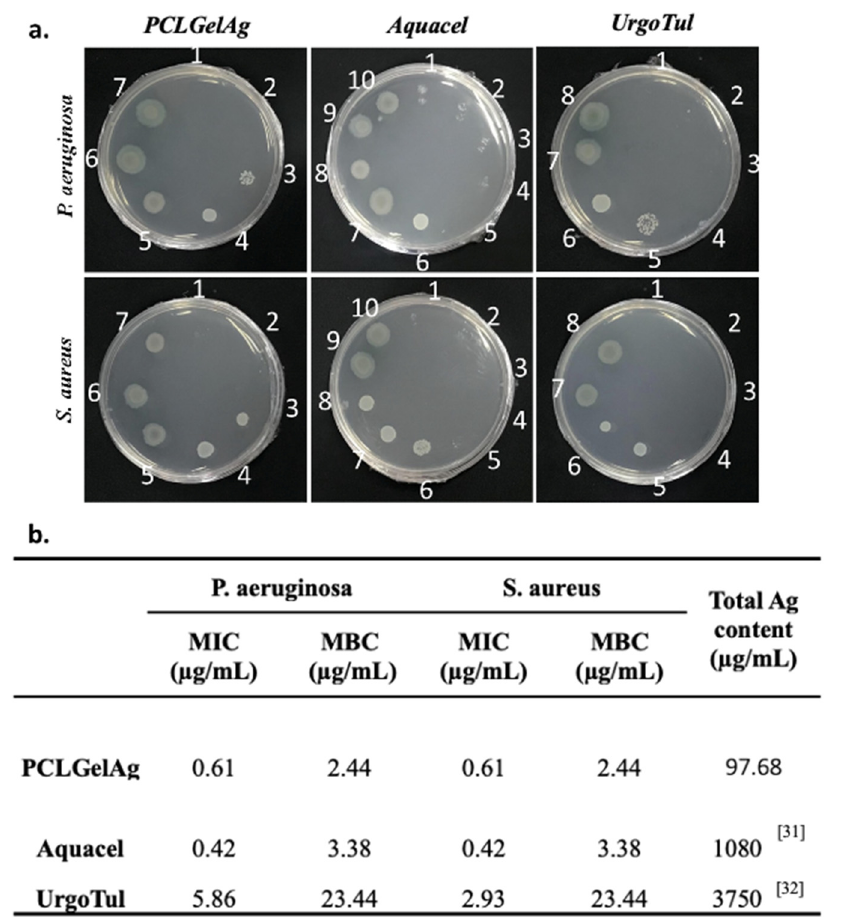
Figure 5. Antibacterial activity of the PCLGelAg, Aquacel and UrgoTul dressings against P. aeruginosa and S. aureus determined by the broth microdilution method. ( a ) Wells that showed no visible bacterial growth will be sampled and cultured on a new MH agar plate. The numbers (from 1 to 10) were the values of x in 2 − x dilution. ( b ) Minimum inhibitory concentration (MIC), minimum bactericidal concentration (MBC) values and the total silver content of PCLGelAg, Aquacel [31], and UrgoTul [32] dressings. The values represent silver concentrations.